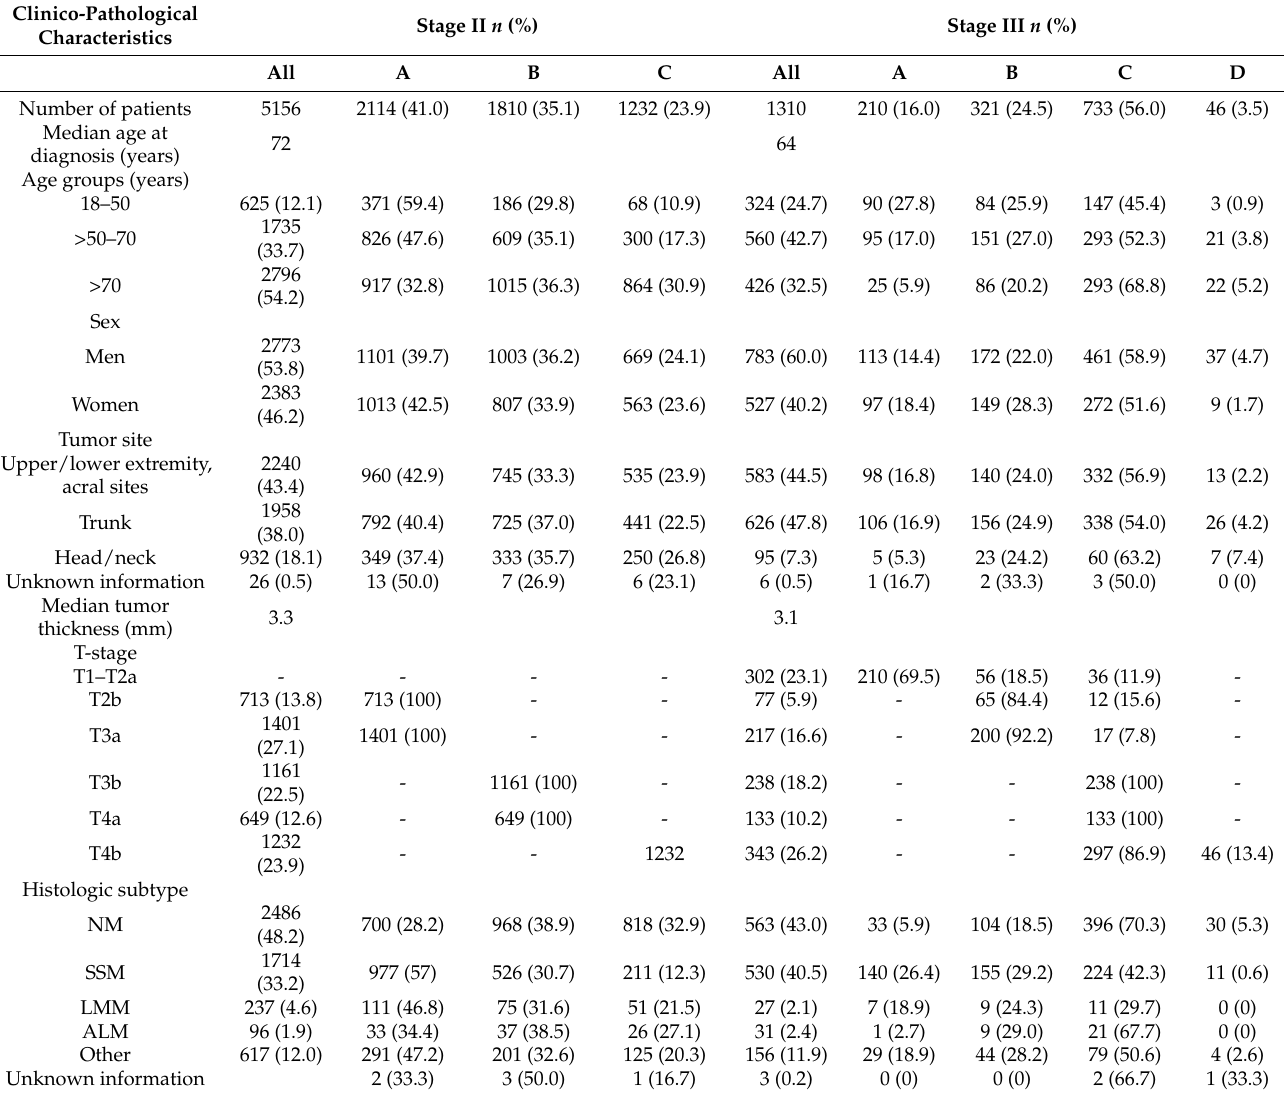
Table 1. Clinicopathological characteristics of patients diagnosed with Stage II–III cutaneous melanoma in Sweden,